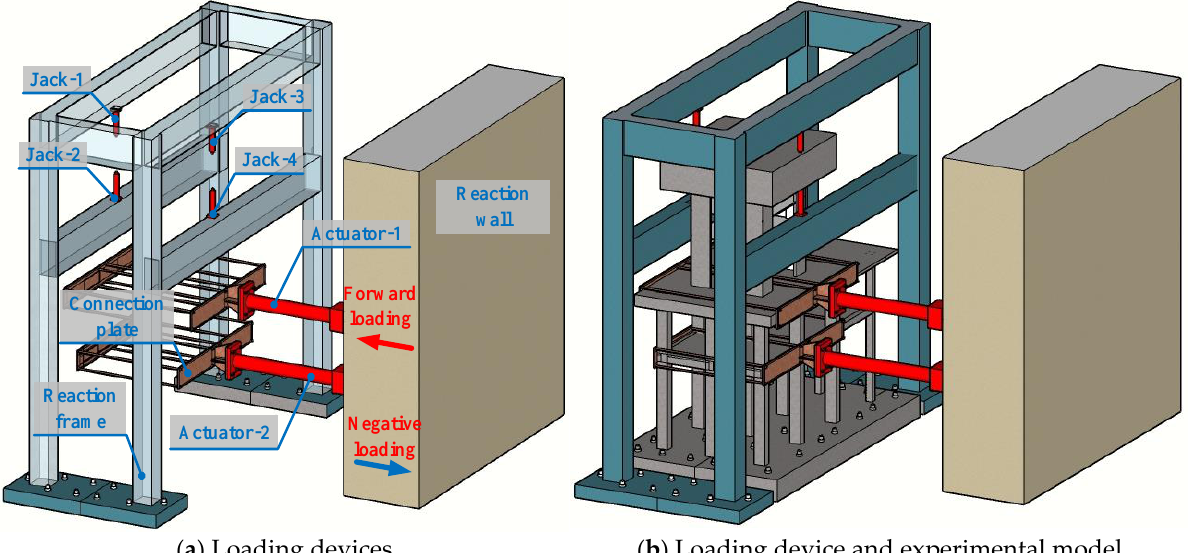
Figure 8. Schematic diagram of loading device and experimental model.